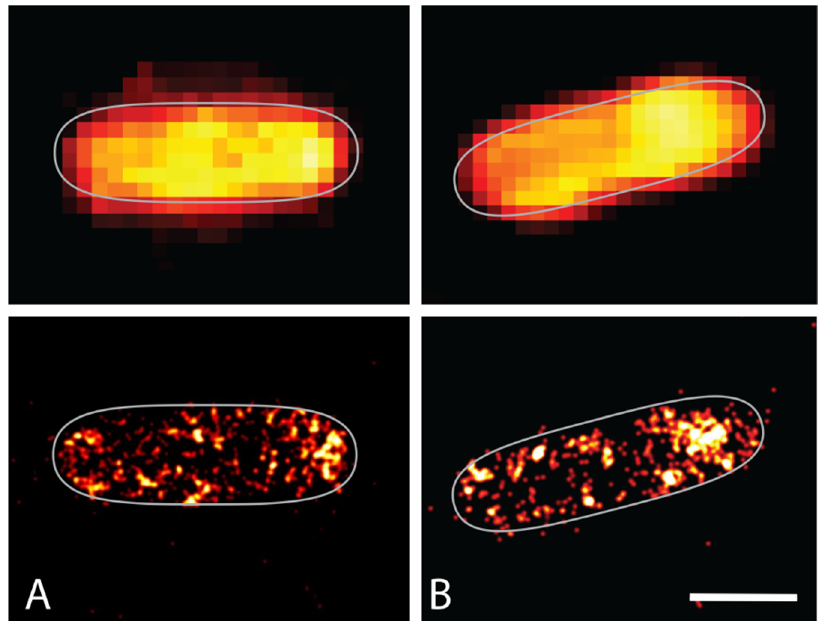
Figure 3. FPALM images of E.coli cells expressing wt YtvA. FPALM images of E. coli cells expressing wt YtvA soaked in isotonic buffer (A) and under de-hydrated conditions (B). Intracellular distribution seems similar for the system in both hydration states, the protein remains widespread over the cell body with some major aggregates at the cell wall. Experimental conditions for the de-hydrated state: Intensity: 0.2 W/cm 2 at 405 nm and 0.05 kW/cm 2 at 488 nm; for the hydrated state: Intensity: 1–2 W/cm 2 at 405 nm and 0.2 kW/cm 2 at 488 nm; frame rate: 30 Hz and total number of collected frames: 20000. Scale bar: 1 m m.